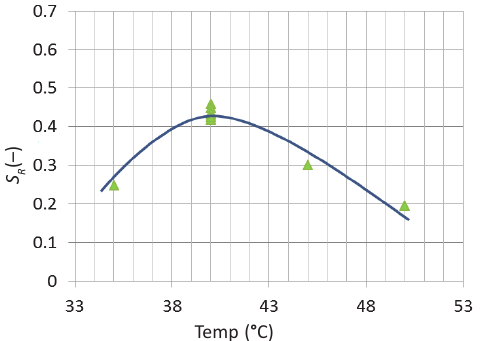
diastereomeric salts of cis -permetric acid and phenylethyl amine were crystallized from CO 2 only, using carbon dioxide as the reaction medium. 20 Fig. 5 Effect of temperature on diastereomeric salt formation. Reaction conditions: 0.5 molar ratio at 12MPa for 1 h.